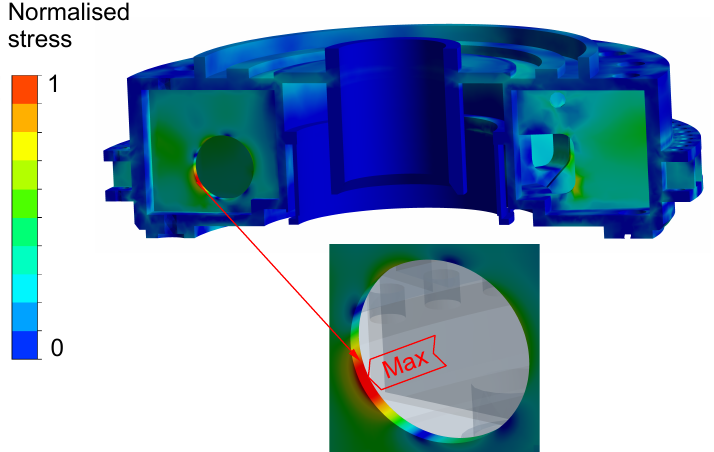
Figure 20. The stress distribution of the head cover. Figure 21 illustrates the stress distribution of the bottom ring during load rejection. The stresses are normalized with reference to the maximum stress value of the bottom ring and the maximum stress of the bottom ring occurs on the corner of the bottom ring flange.